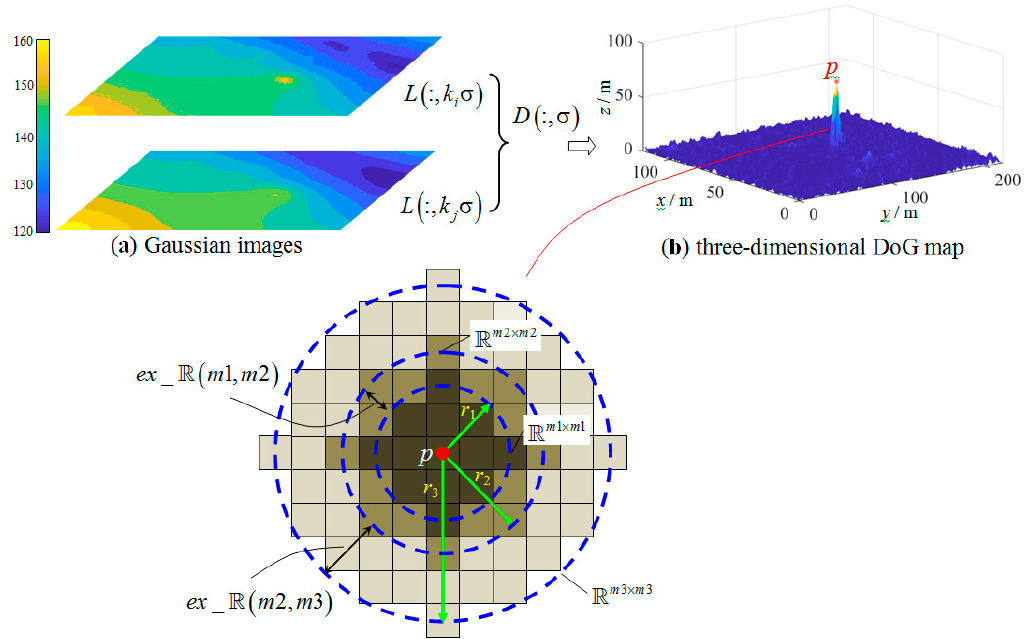
Figure 6. Example of the DoG operation and noisy point detection. DoG: difference of Gaussian.